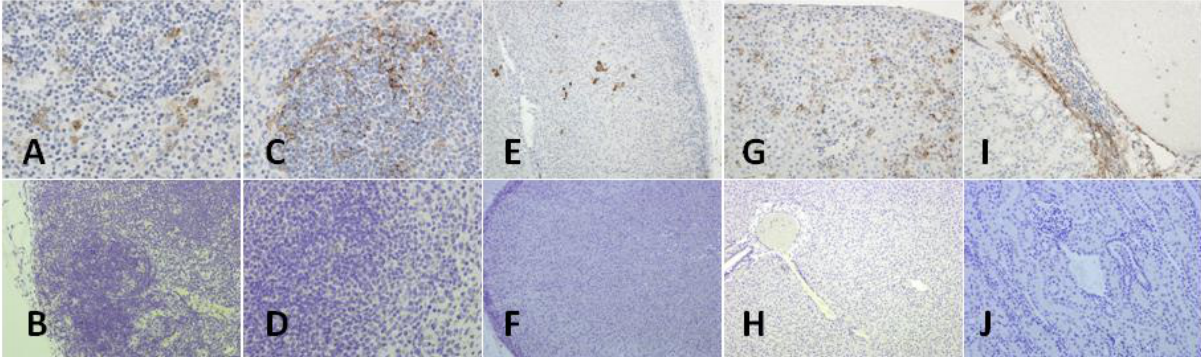
Figure 4. Immunohistochemistry staining for LASV antigen in selected tissues of mock-vaccinated or ELGEN-MID-vaccinated guinea pigs. ( A ) Viral antigen staining of a mock-vaccinated lymph node (40×); ( B ) lymph node of a ELGEN-MID-vaccinated animal showing lymphoid hyperplasia and a lack of viral staining (20×); ( C ) Viral antigen staining of a mock-vaccinated spleen (40×); ( D ) Splenic white pulp hyperplasia in a ELGEN-MID- vaccinated guinea pig (40×); ( E ) Viral antigen staining of a mock-vaccinated adrenal gland (10×); ( F ) A lack of viral antigen staining of a ELGEN-MID-vaccinated adrenal gland (10×); ( G ) Viral antigen staining of a mock-vaccinated liver (20×); ( H ) A lack of viral antigen staining of a ELGEN-MID-vaccinated liver (10×); ( I ) Viral antigen staining of a mock- vaccinated kidney (20×); ( J ) A lack of viral antigen staining of a ELGEN-MID-vaccinated kidney